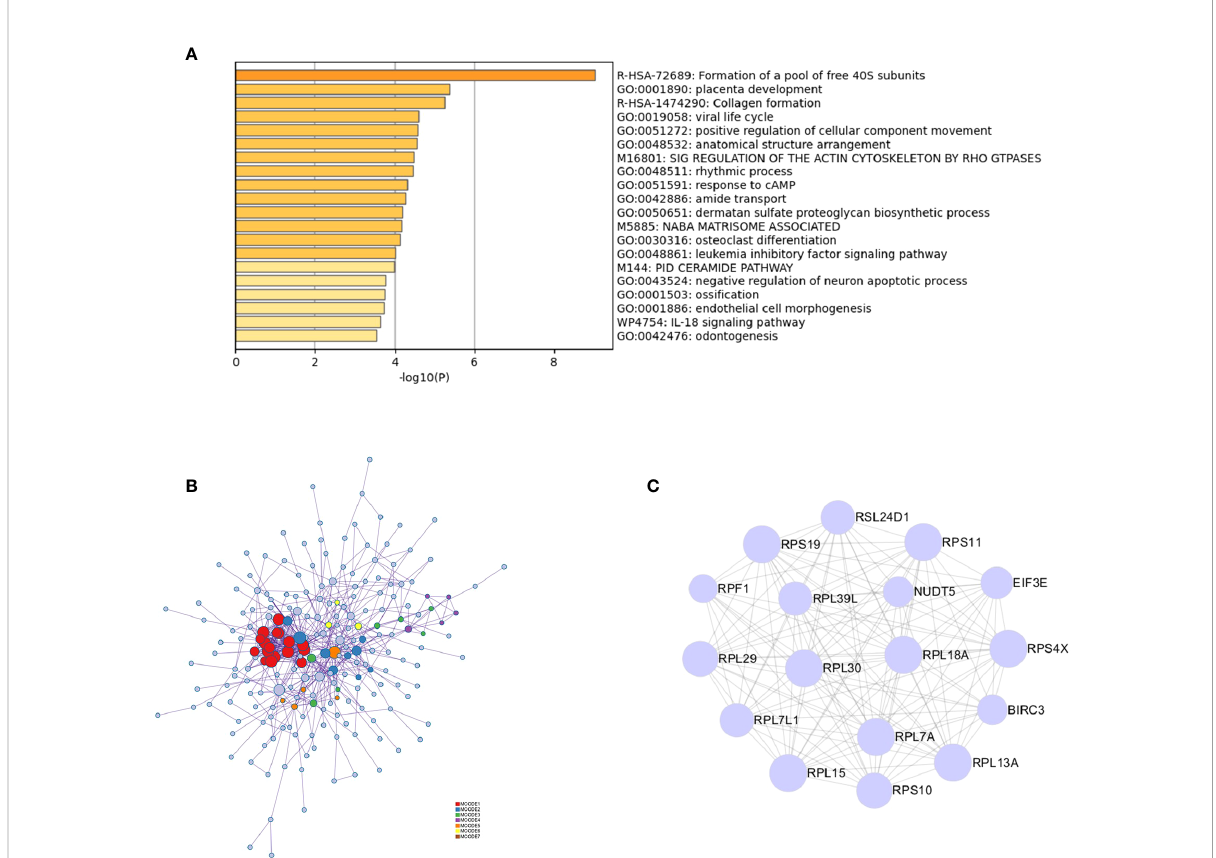
algorithm in Cytoscape to obtain the highest scoring gene